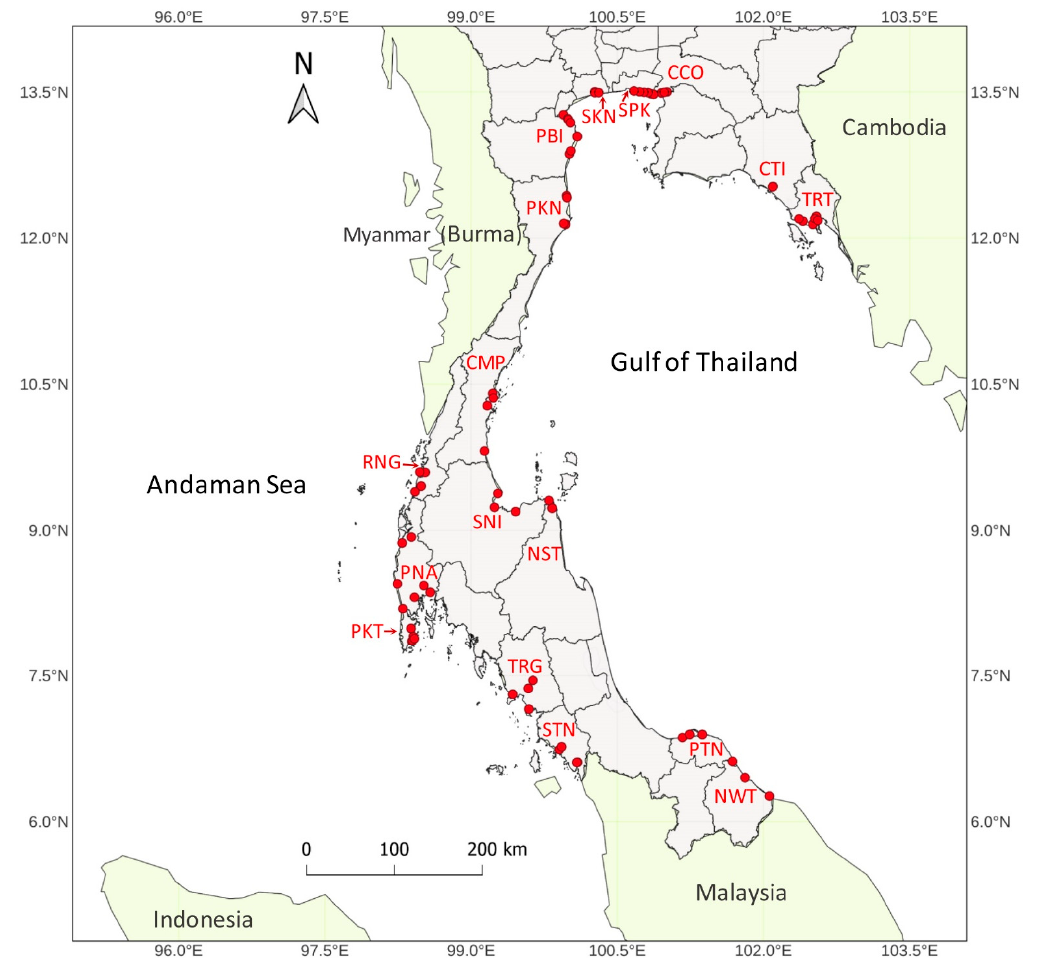
Figure 2. The geographical location of 82 R. apiculata accessions in Thailand. Collection sites in 17 provinces are Chachoengsao (CCO), Chumphon (CMP), Chanthaburi (CTI), Nakhon Si Thammarat (NST), Narathiwat (NWT), Phetchaburi (PBI), Prachuap Khiri Khan (PKN), Phuket (PKT), Phang-nga (PNA), Pattani (PTN), Ranong (RNG), Samut Sakhon (SKN), Surat Thani (SNI), Samut Prakan (SPK), Satun (STN), Trang (TRG), and Trat (TRT). Red dots indicate collection sites at which the accessions were collected.